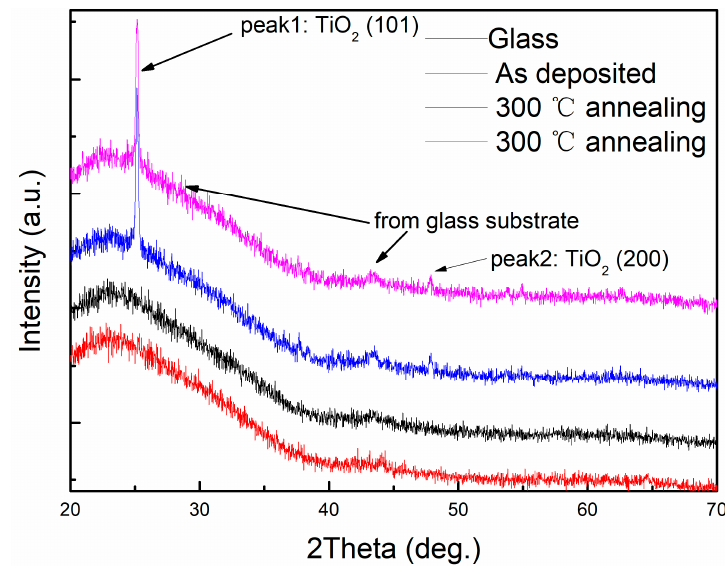
Figure 4. XRD patterns of multilayers annealed at different temperatures.